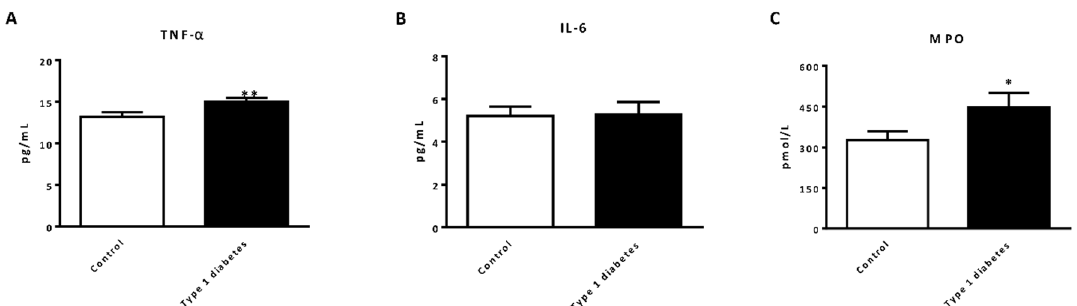
Figure 3. Evaluation of serum levels of cytokines and mediators of inflammation in type 1 diabetic and control subjects. ( A ) Serum levels of TNFα (pg/mL); ( B ) Serum levels of IL-6 (pg/mL); ( C ) Serum levels of MPO (pmol/L). Data are expressed as mean ± SEM. * p < 0.05, ** p < 0.01 control vs. type 1 diabetic subjects. Abbreviations: IL-6, interleukin 6; MPO, myeloperoxidase; TNFα: tumor necrosis factor alpha.